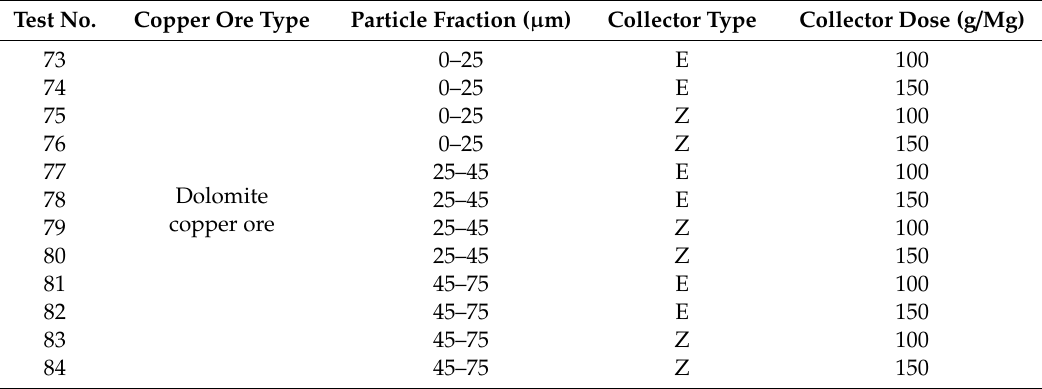
Table 6. The variability range of parameters of the flotation test planned and carried out according to the experimental plan (E—aqueous solution of ethyl sodium xanthate; Z—aqueous solution of isobutyl sodium xanthate)—Jameson cell, dolomite copper ore. Test